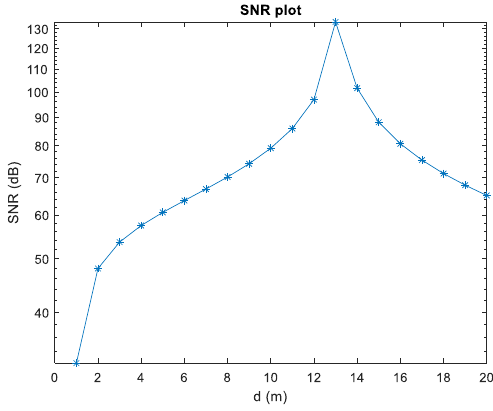
Fig. 6. The relation between the SNR and the distance